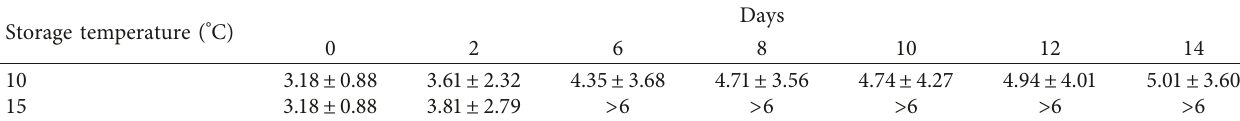
Figure 2: pH value (a), odor intensity (b), and VBN level (c) of the processed squid stored at different temperatures. Values are mean ± SD ( n � 10). Different letters (A–C) indicate significant differences among means by Tukey’s test at p < 0 . Table 9: Total bacterial count of processed squid stored at different temperatures.